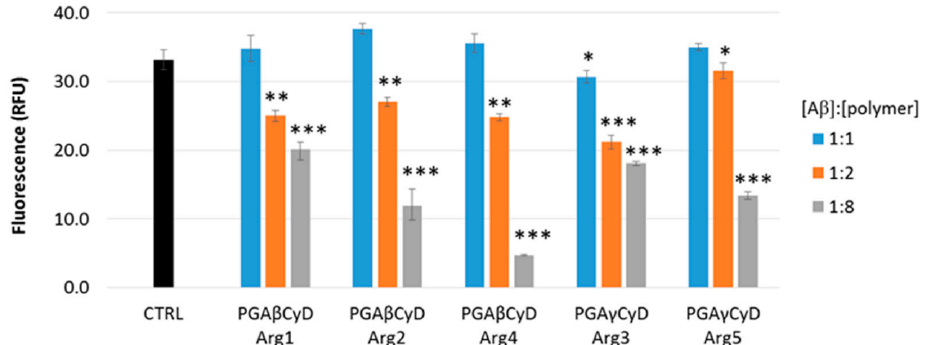
Figure 4. Maximum fluorescence gain values ( F max − F 0 ) of the samples containing A β 1-40 (20 µ M) alone (control (CTRL)) or in the presence of the PGA polymers, the (A β )/(Polymer) molar ratio ranging from 1:1 to 1:8. (* p < 0.05, ** p < 0.01, *** p < 0.001 vs. CTRL, ANOVA test).